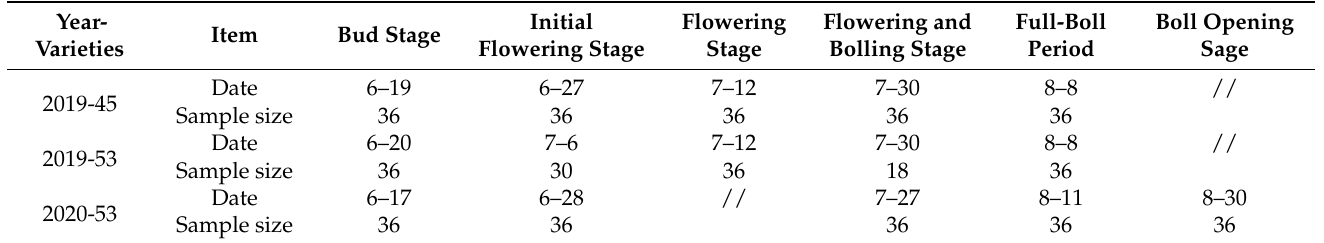
Table 2. Sample acquisition time and sample